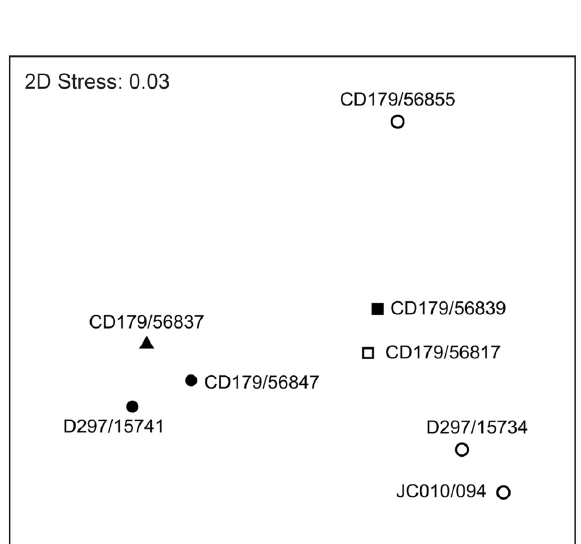
Fig. 3. MDS plot of all canyon samples. Samples coded by canyon (circles, Nazar´e Canyon; squares, Set´ubal Canyon; triangles, Cas- cais Canyon) and depth (open symbols, middle canyon; filled sym- bols, lower canyon). Sample number shown next to each